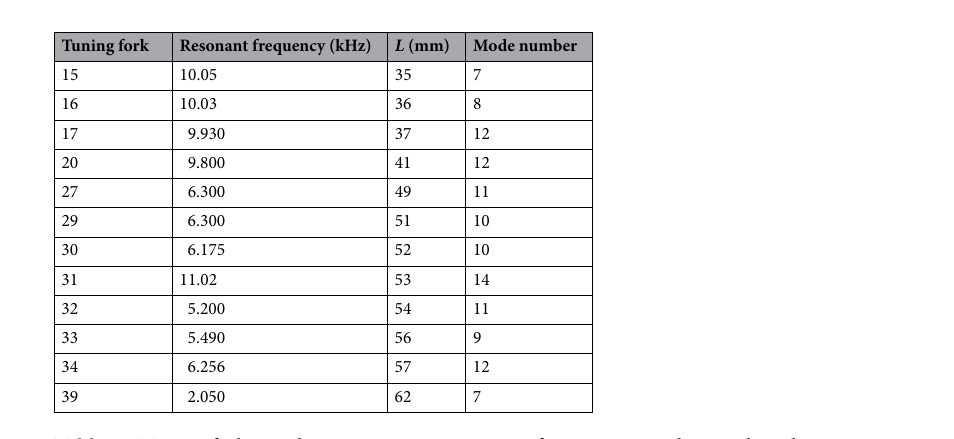
Table 1. Tuning forks used in experiments, resonant frequencies, and prong